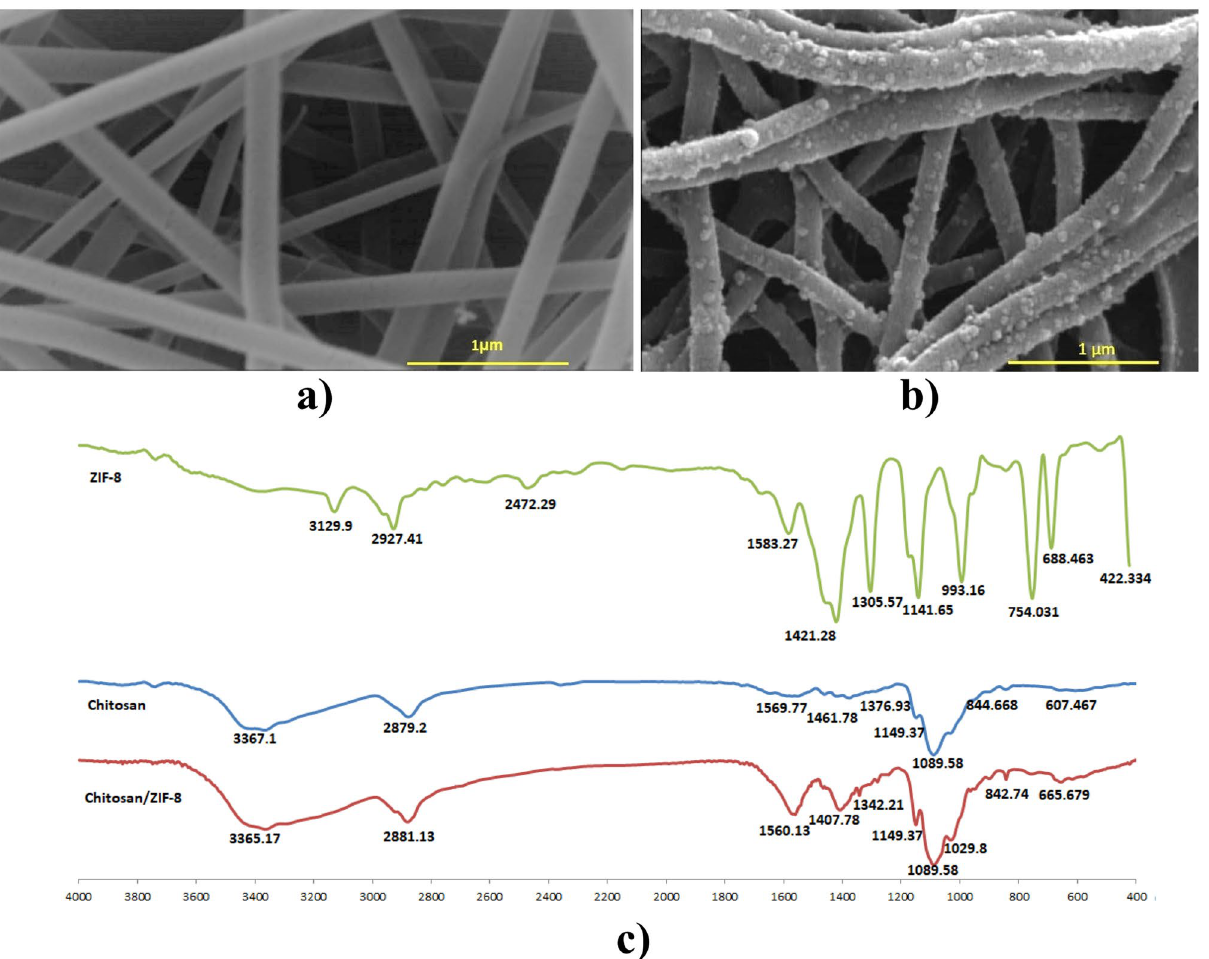
Figure 2. Characteristics of electrospun films formed on the surface of AZ91 magnesium alloy. Top-view SEM images of ( a ) chitosan and ( b ) MOF/chitosan coatings. ( c ) FTIR spectrum of chitosan, ZIF-8, and MOF/ chitosan composite